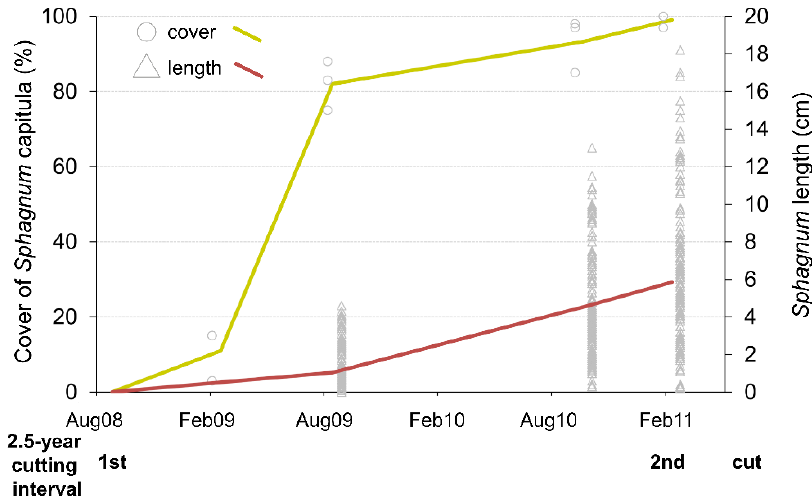
Figure 4. Development of mean Sphagnum capitula cover and mean length after cutting S. papillosum at depth 5 cm on plots (cover) and sampling squares (length) at the Ramsloh Sphagnum farming field (Germany). Each column of grey symbols represents the individual measurements on one date, and the lines represent mean values (see